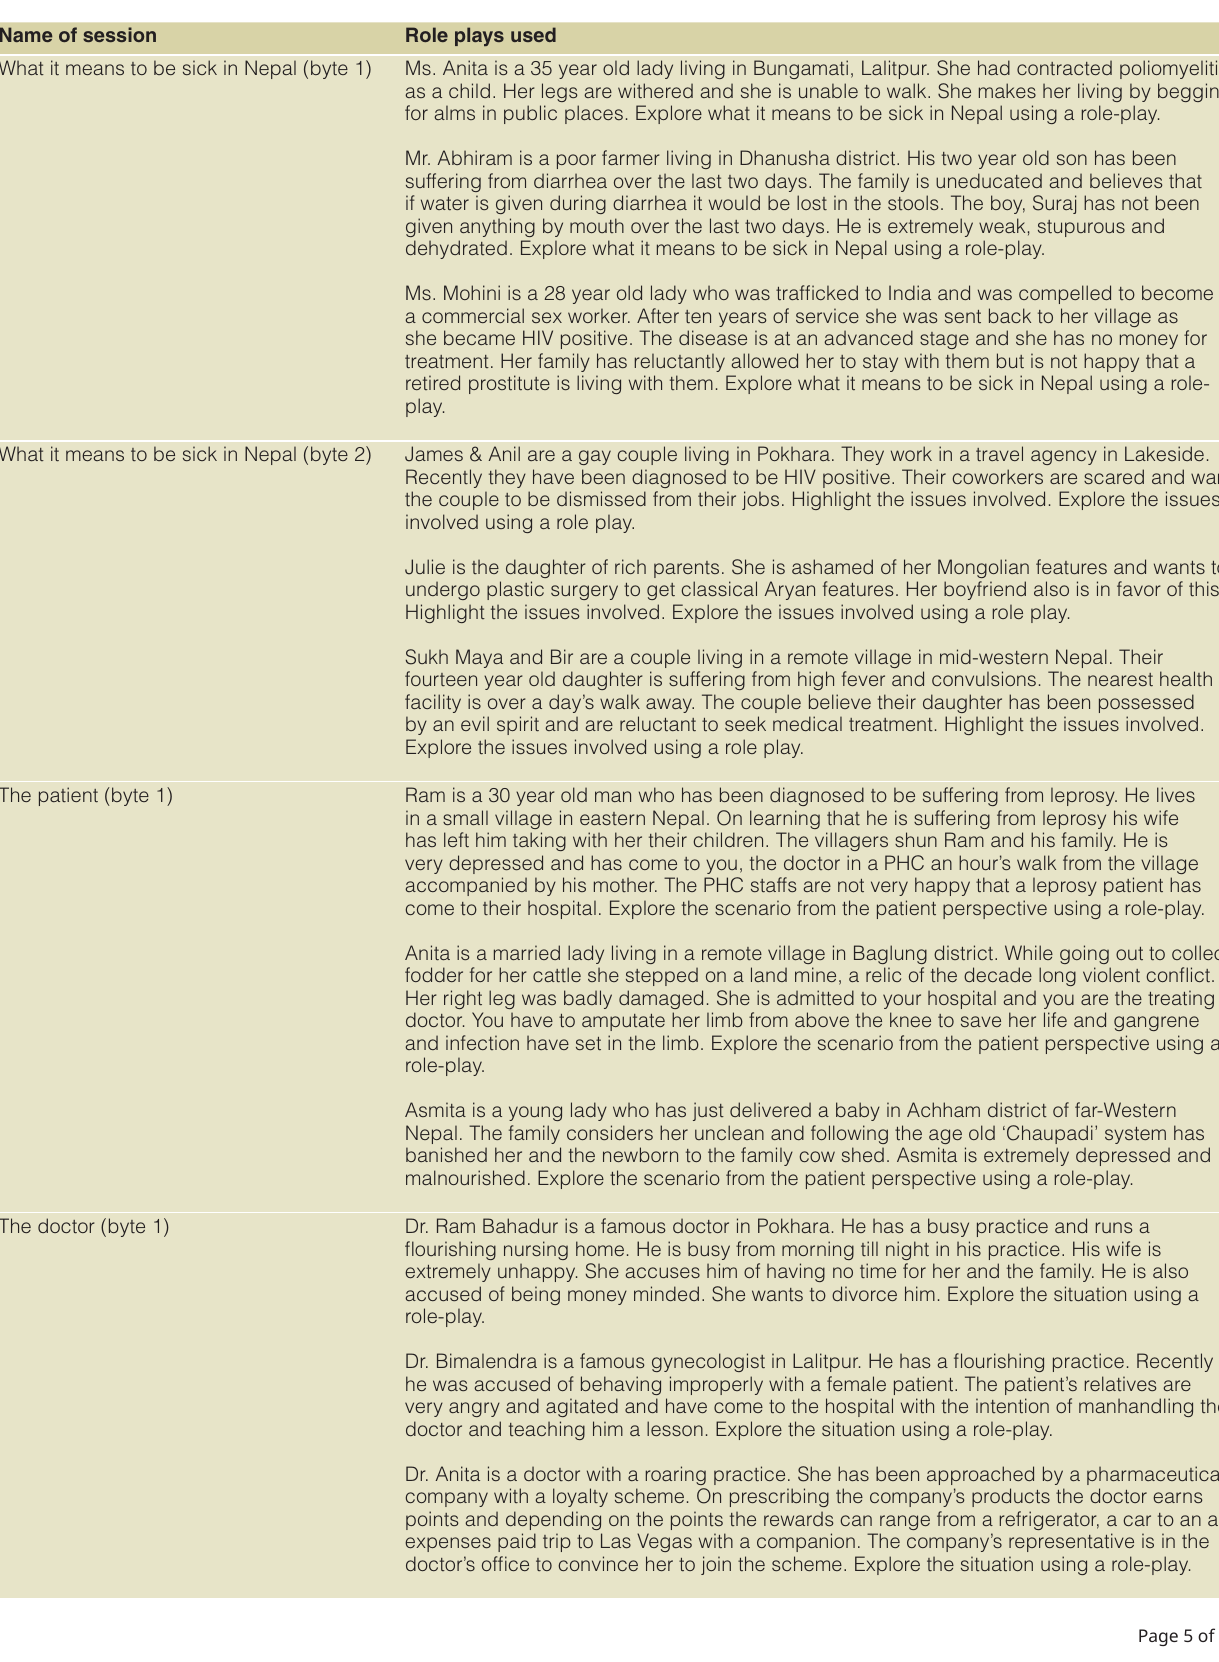
Table 1. Role plays used during the medical humanities module. Name of